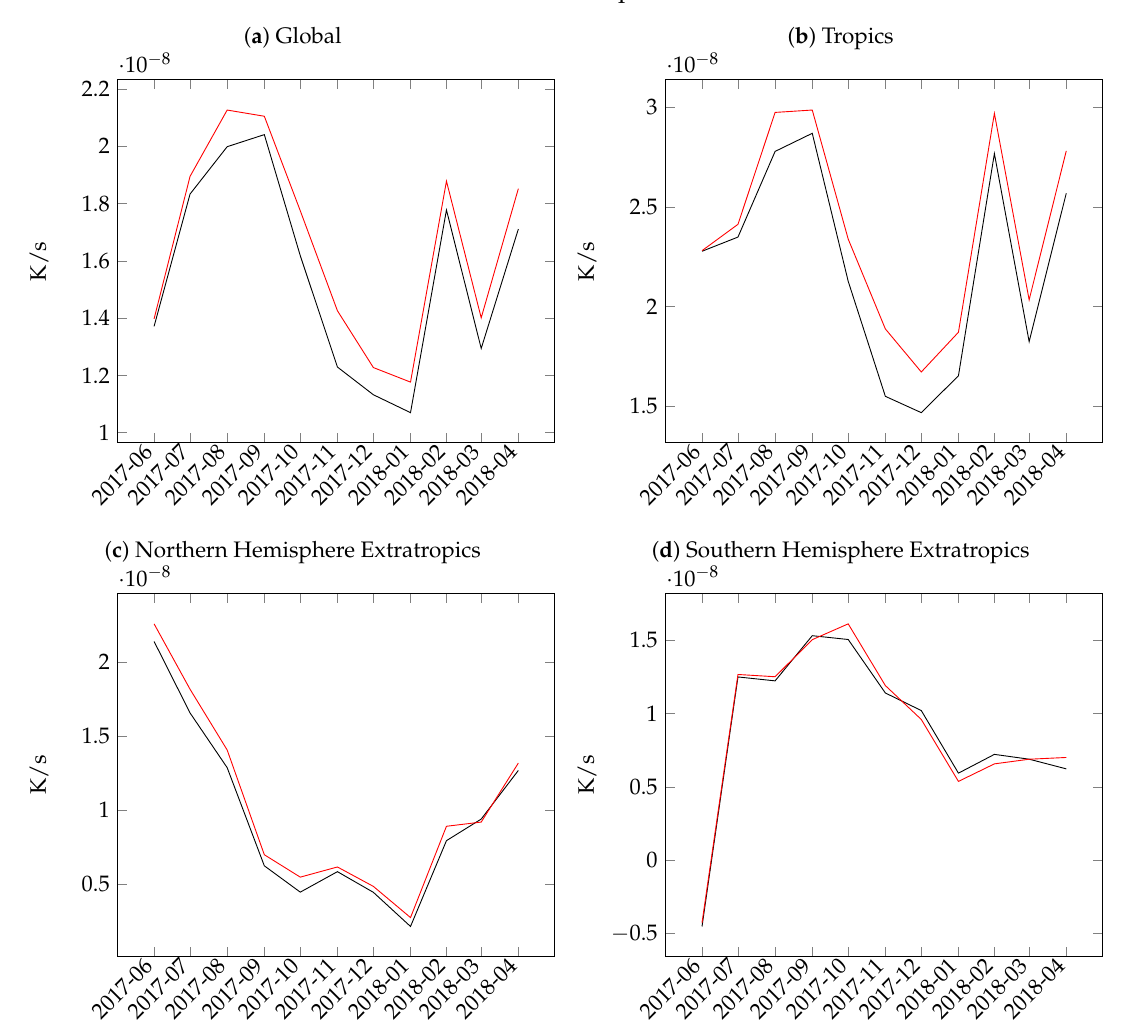
Figure 12. As in Figure 11 but for surface assimilation temperature